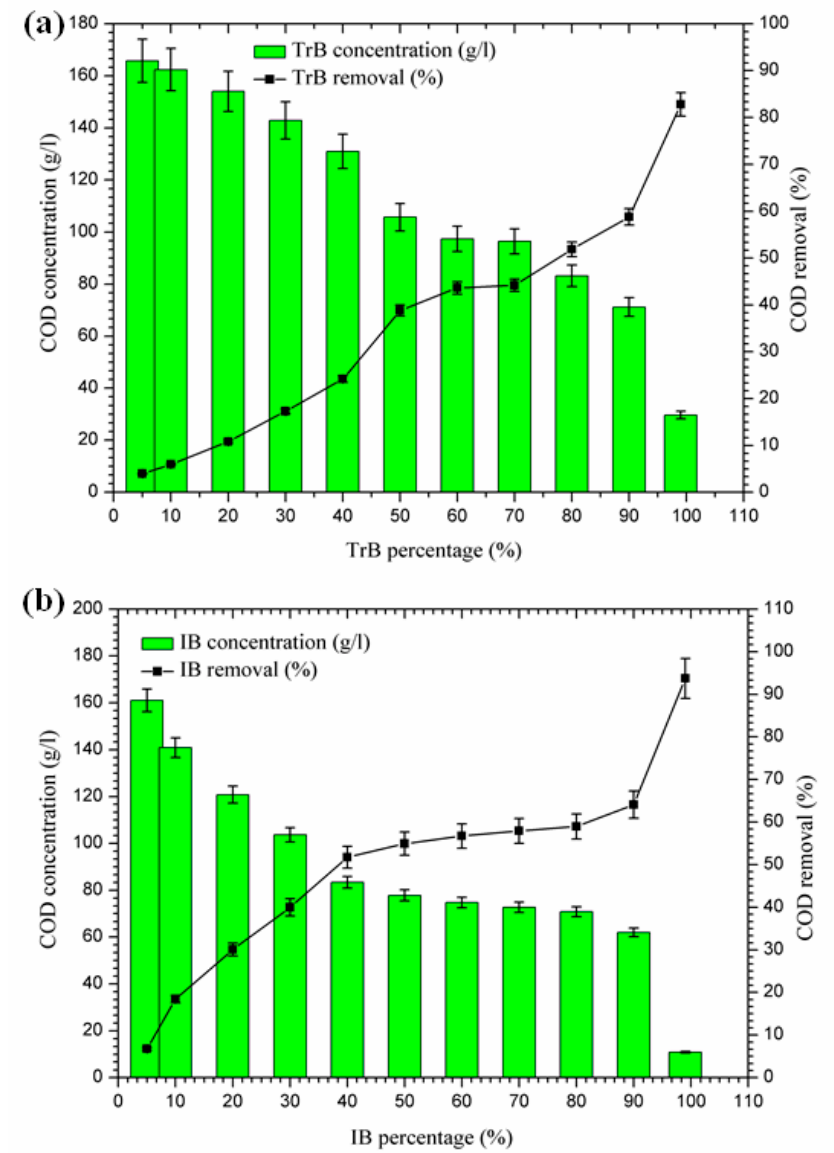
Figure 6. ( a ) Concentration and removal percentage of COD by TrB; ( b ) concentration and removal percentage of COD by IB.